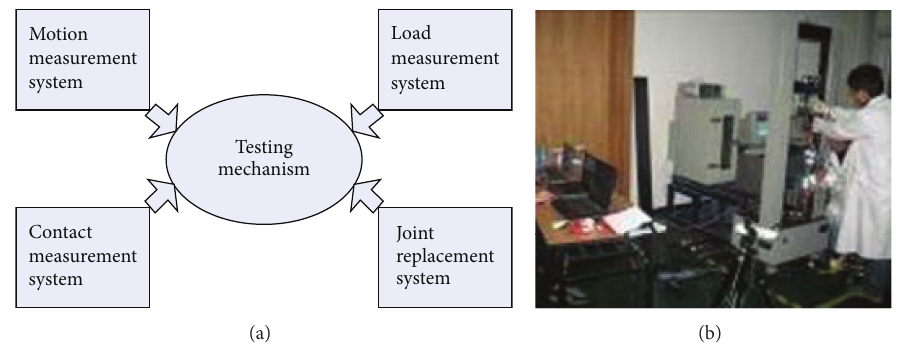
Figure 3: The flowchart and the real of knee experiment